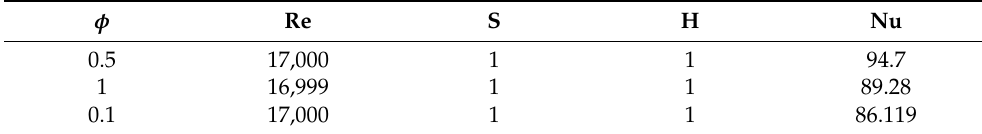
Table 4. Optimised factors at maximum